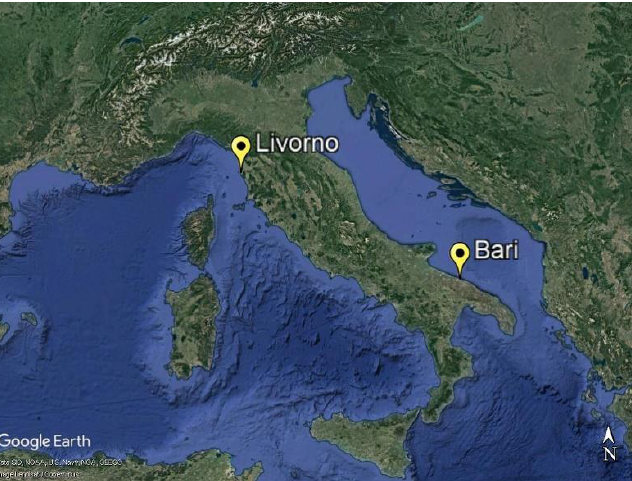
Figure 1. The test sites in Livorno and Bari harbours, in Italy (image from Google Earth).